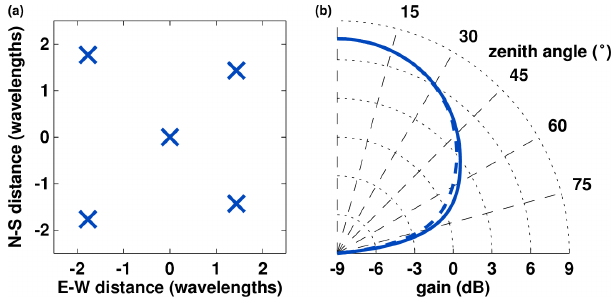
Figure 1. (a) Overhead view of the NSMR receive array, with el- ements (blue line segments) to scale. (b) Gain pattern as a func- tion of zenith angle for an individual NSMR antenna azimuthally aligned/perpendicular to elements (solid blue line) and 45 ◦ between elements (dashed blue